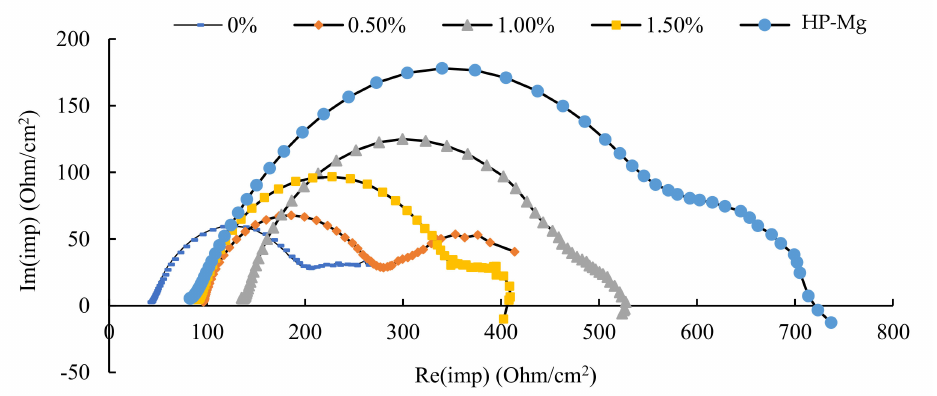
Figure 4. Nyquist plots of the measured impedances for the Mg-Sm 2 O 3 nanocomposites group. Table 2. Summary of electrochemical corrosion characteristics of Mg-Sm 2 O 3 nanocomposites. EIS Test